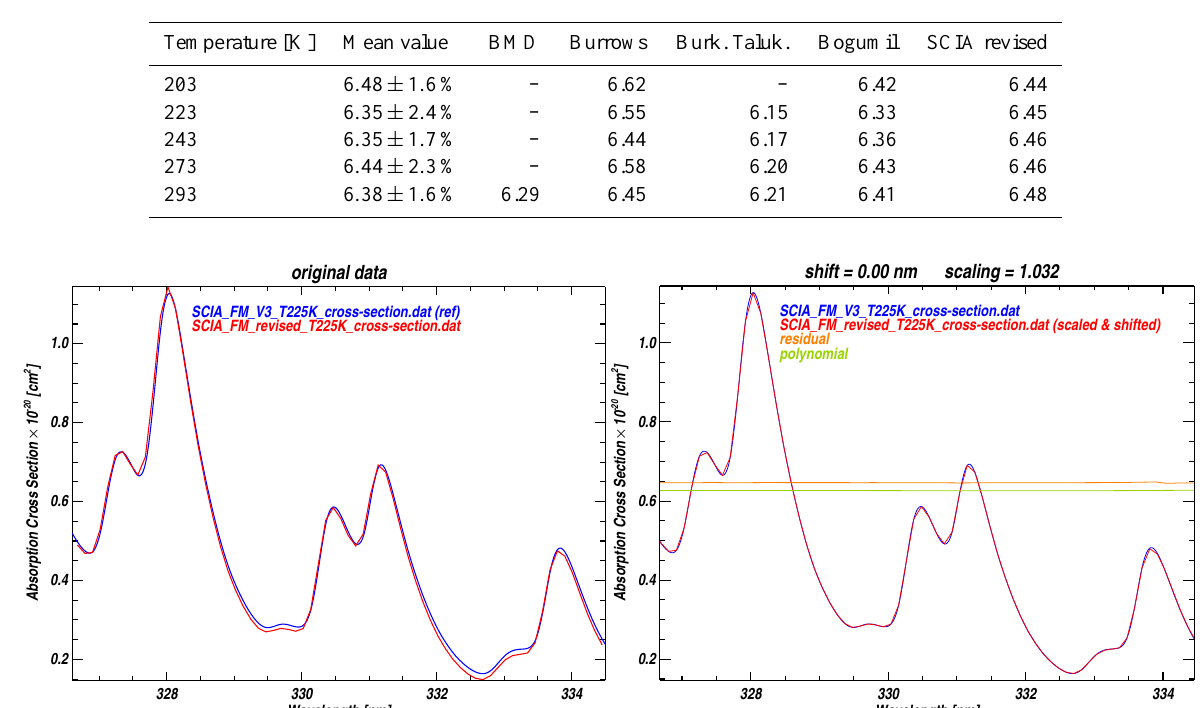
Table 3. Comparison of integrated cross sections in the Chappuis band (410–690nm) in units of 10 − 19 cm 2 nmmolecule − 1 .